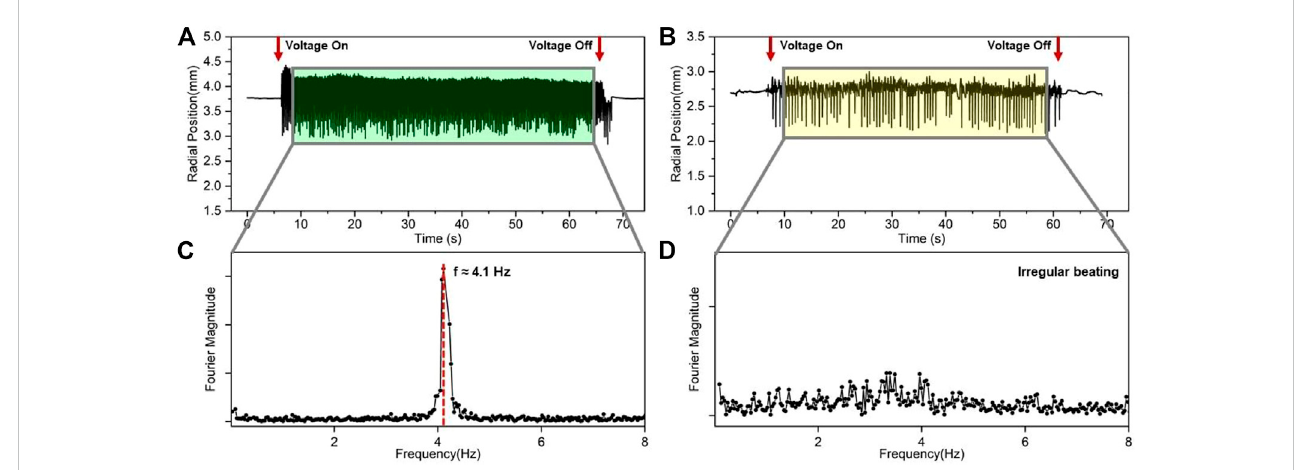
Regularandirregularbeatings. (A) Schematicdiagramofdisplacementversustimewhen120- μ LeGaIndropbeatingsinthe0.5 mmratchetsubstratesin the channel direction. (B) Schematic diagram of displacement versus time when 60- μ L eGaIn drop beatings in the 0.5 mm ratchet substrates in the